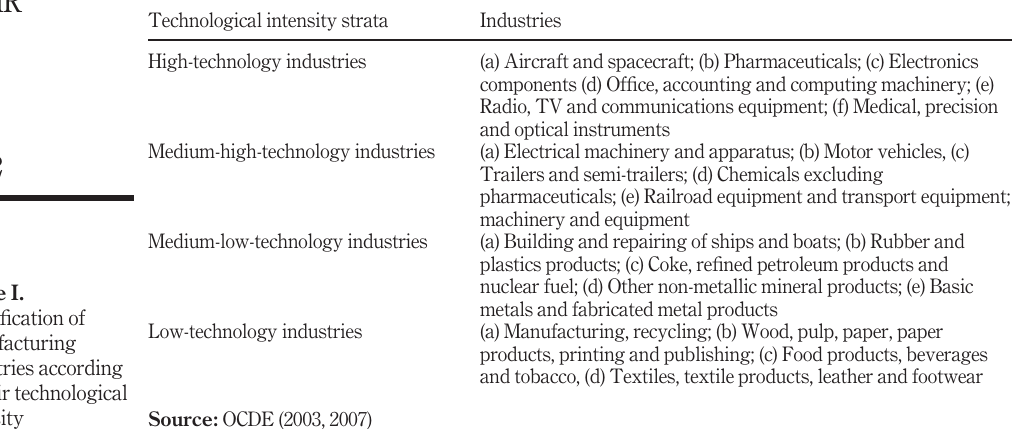
Technological intensity strata Industries High-technology industries